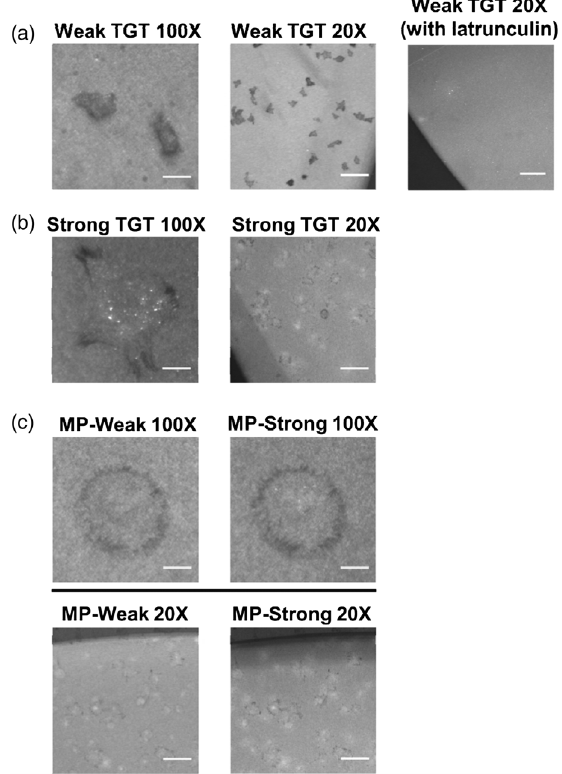
FIG. 2. Fluorescence images of TGT rupture with and without multiplexing. (a) Fluorescent images on the weak TGT-coated surface in 20X and 100X magnifications show uniformly dark patches beneath the cell (uniform rupture). However, when we inhibited actin polymerization by adding 1 μ M latrunculin A to the cell culture medium, cells did not show rupture footprint. (b) Fluorescent images on the strong TGT-coated surface show fluorescence loss mostly at the periphery of the cell (edge rupture). Bright spots are probably the vesicles containing the upper strand of ruptured TGT that have undergone endocytosis. (c) Fluorescence loss patterns of weak and strong TGTs are similar and show “ edge rupture ” on the multiplex TGT surface. Scale bars are 50 μ m for 20X and 10 μ m for